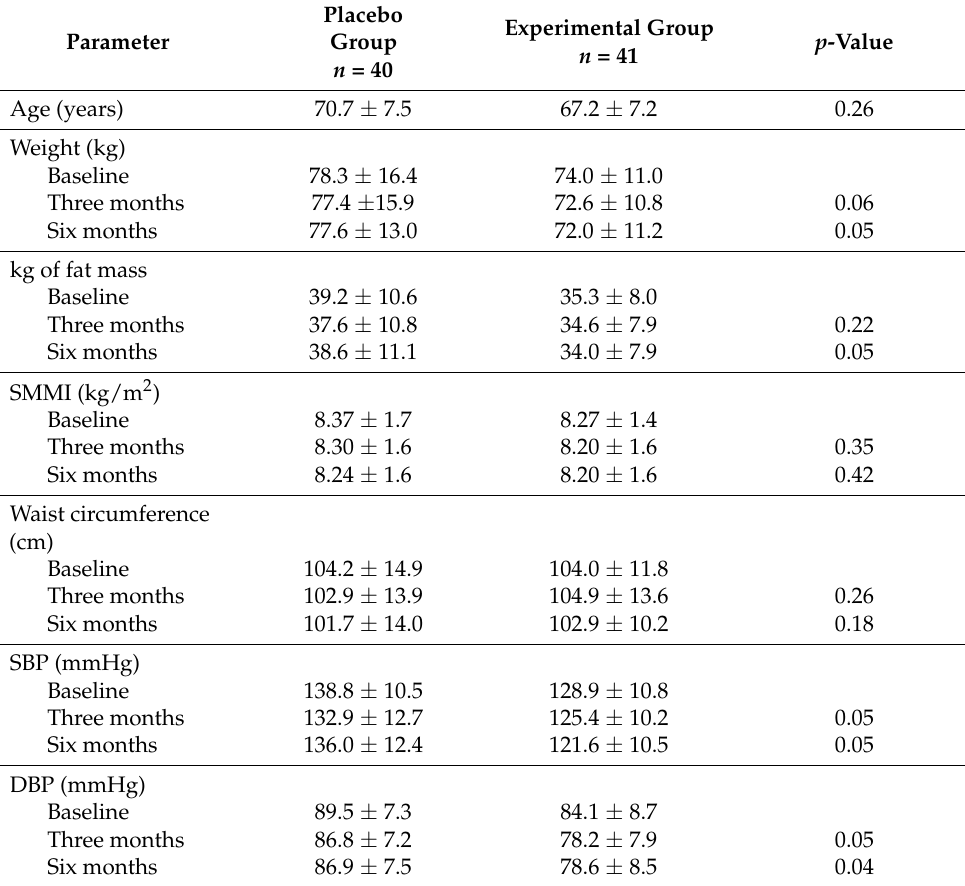
Table 1. Clinical and anthropometric parameters by study